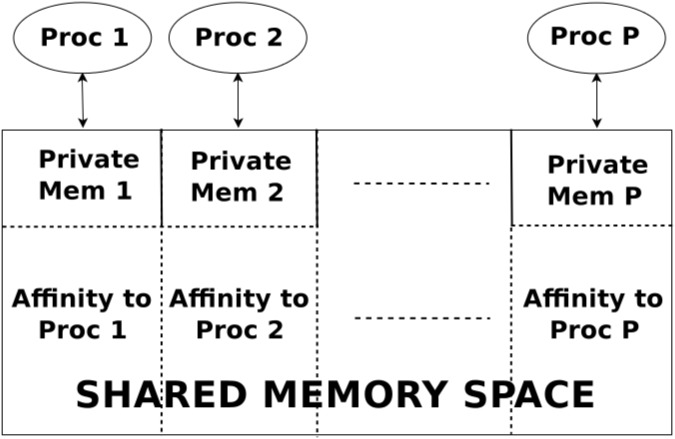
UPC++ memory model.